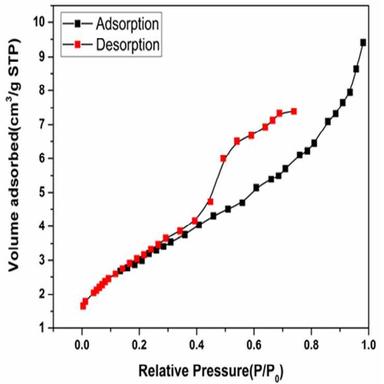
.Nitrogen adsorbed and desorbed isotherms